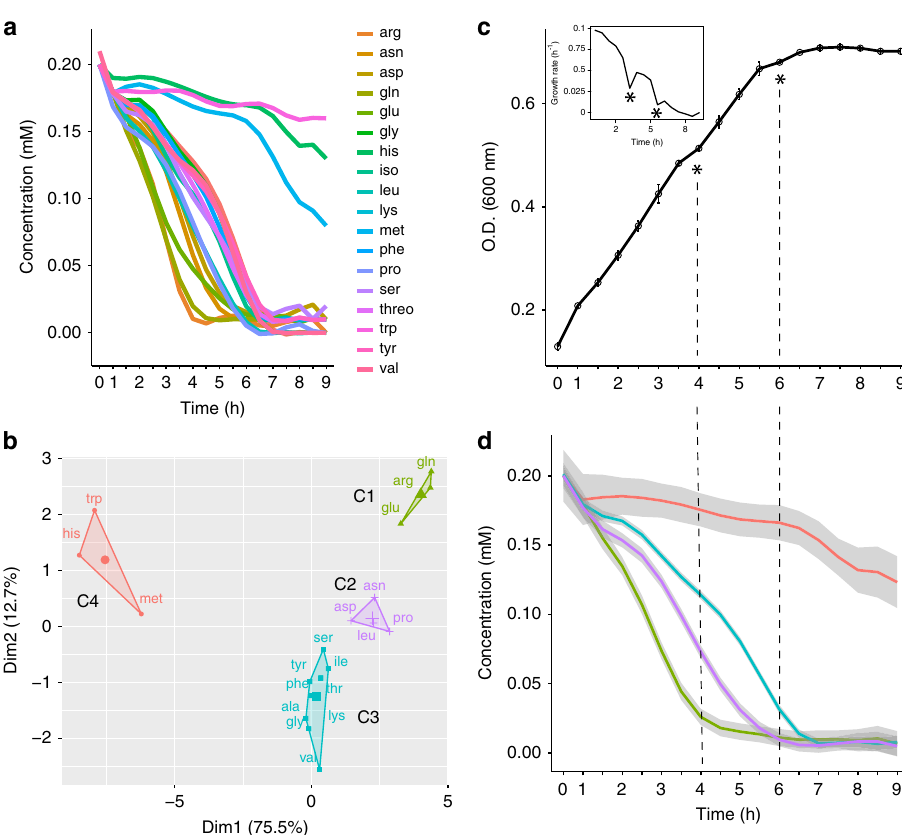
Fig. 4 Amino acids assimilation pro fi les. a Degradation dynamics for each of the 19 amino acids included in the de fi ned AA medium. b Clustering of time- resolved concentration values for the 19 amino acids analyzed. Error bars represent SD of two different cell cultures in two independent experiments. c Growth curve of the 19 amino acids experiment. Asterisks indicate growth lags. d Degradation dynamics for each of the four identi fi ed clusters of amino acids included in the de fi ned AA medium. Colour codes as in b . Grey shaded area includes the 95% con fi dence of the linear regression (coloured) line over the concentrations of the amino acids belonging to the same group. Source data are provided as a Source Data fi le.